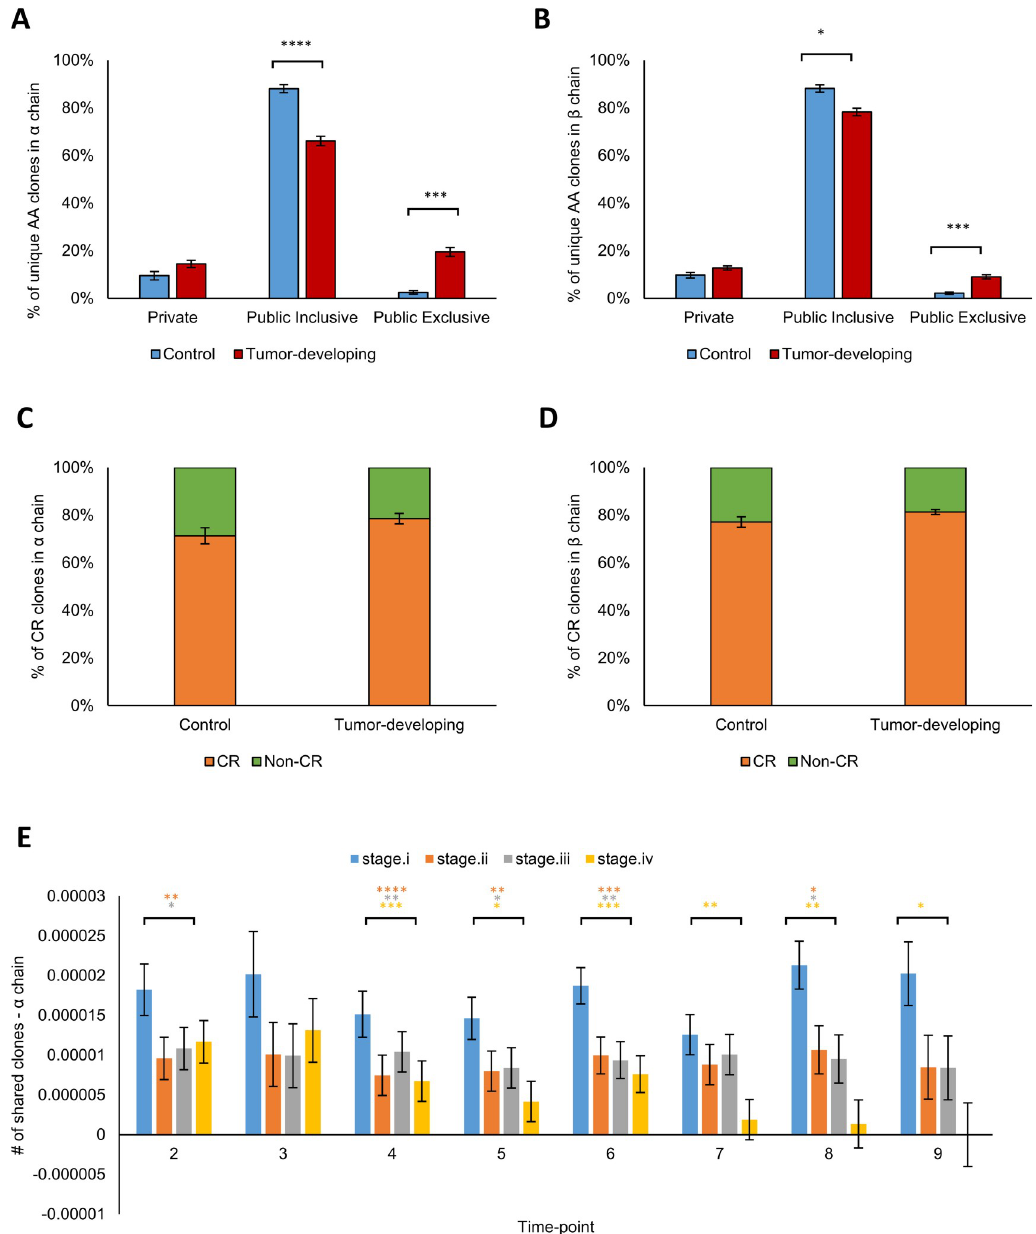
Fig 6. The relationship between TCR clones and different breast cancer stages. Public repertoires of the TCGA-associated TCR clones and their subtypes are shown in tumor-developing mice and in Control mice for α chain (A) and β chain (B) . Frequency of Convergent recombined clones shared between TCGA samples and mouse samples in α (C) and β chain (D) . (E) Frequency of shared clones between TCGA samples and tumor-developing mice in different stages of breast cancer in α chain clones. For each sample, we calculated the number of shared clones according to the following formula: (Shared clones between sample and stage) / (# of clones in a sample x # of total cases of a stage).